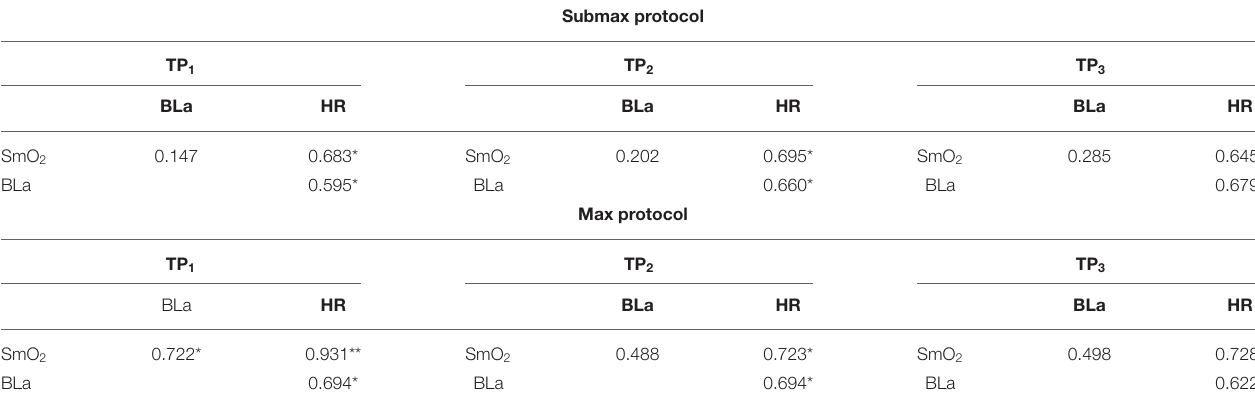
TABLE 2 | Pearson’s correlation magnitudes between the different testing procedures at all testing points during both protocols.